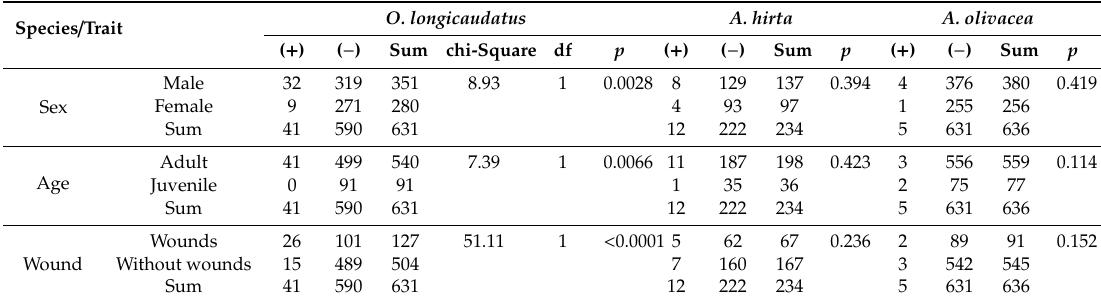
Table 2. Results of contingency test of three seropositive species versus sex, age and wounds. O. longicaudatus Species / Trait